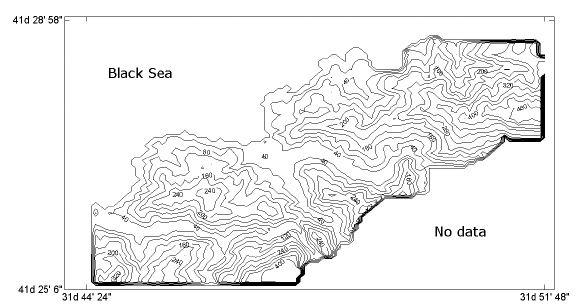
Figure 5. Contour plot of DEM generated from 1:2000 topographic maps. East and west coordinates are with WGS-84 geographic coordinates.